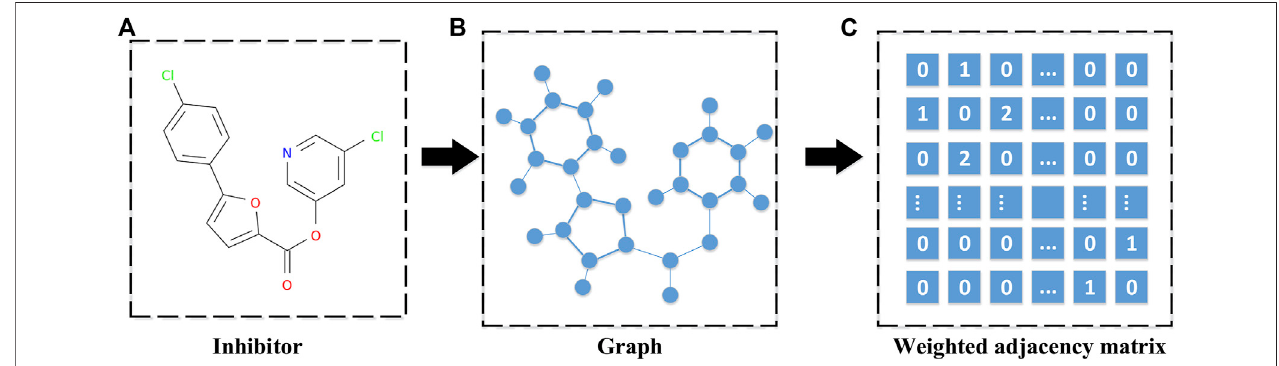
FIGURE3| Adiagramforweightedadjacencymatrixofagiveninhibitor. (A) Thethree-dimensionalmolecularstructureofaninhibitor. (B) Thecorrespondinggraph of the inhibitor ’ s molecular structure, which is obtained by treating the atoms in the molecular structure as nodes and the bonds in the molecular structure as edges. (C) The weighted adjacency matrix of the inhibitor ’ s graph, and the weight determined by the type of chemical bond, where the single bond is 1 and the double bond is 2.